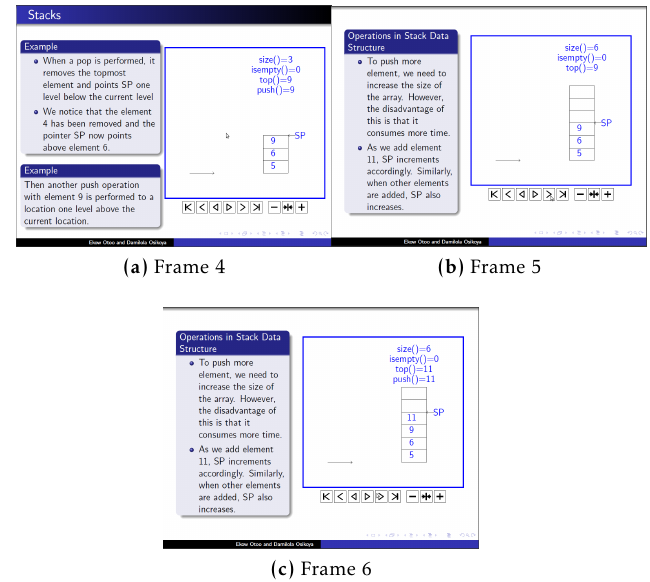
Figure 3. Stack Implementation